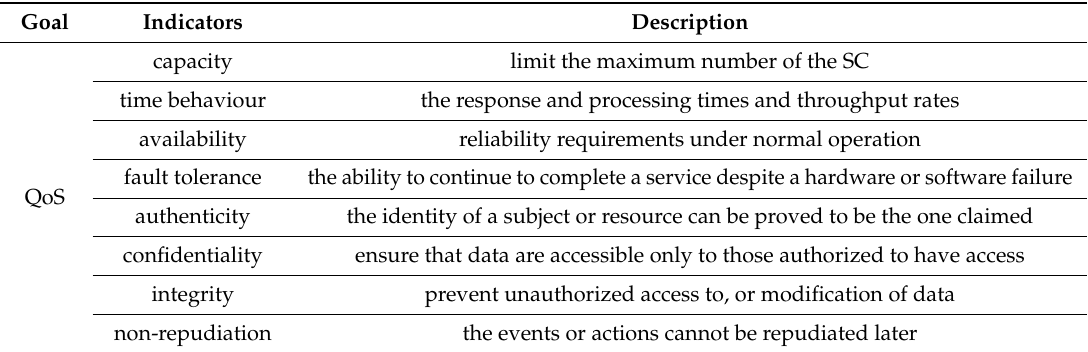
Table 1. The quality of service (QoS) evaluation index